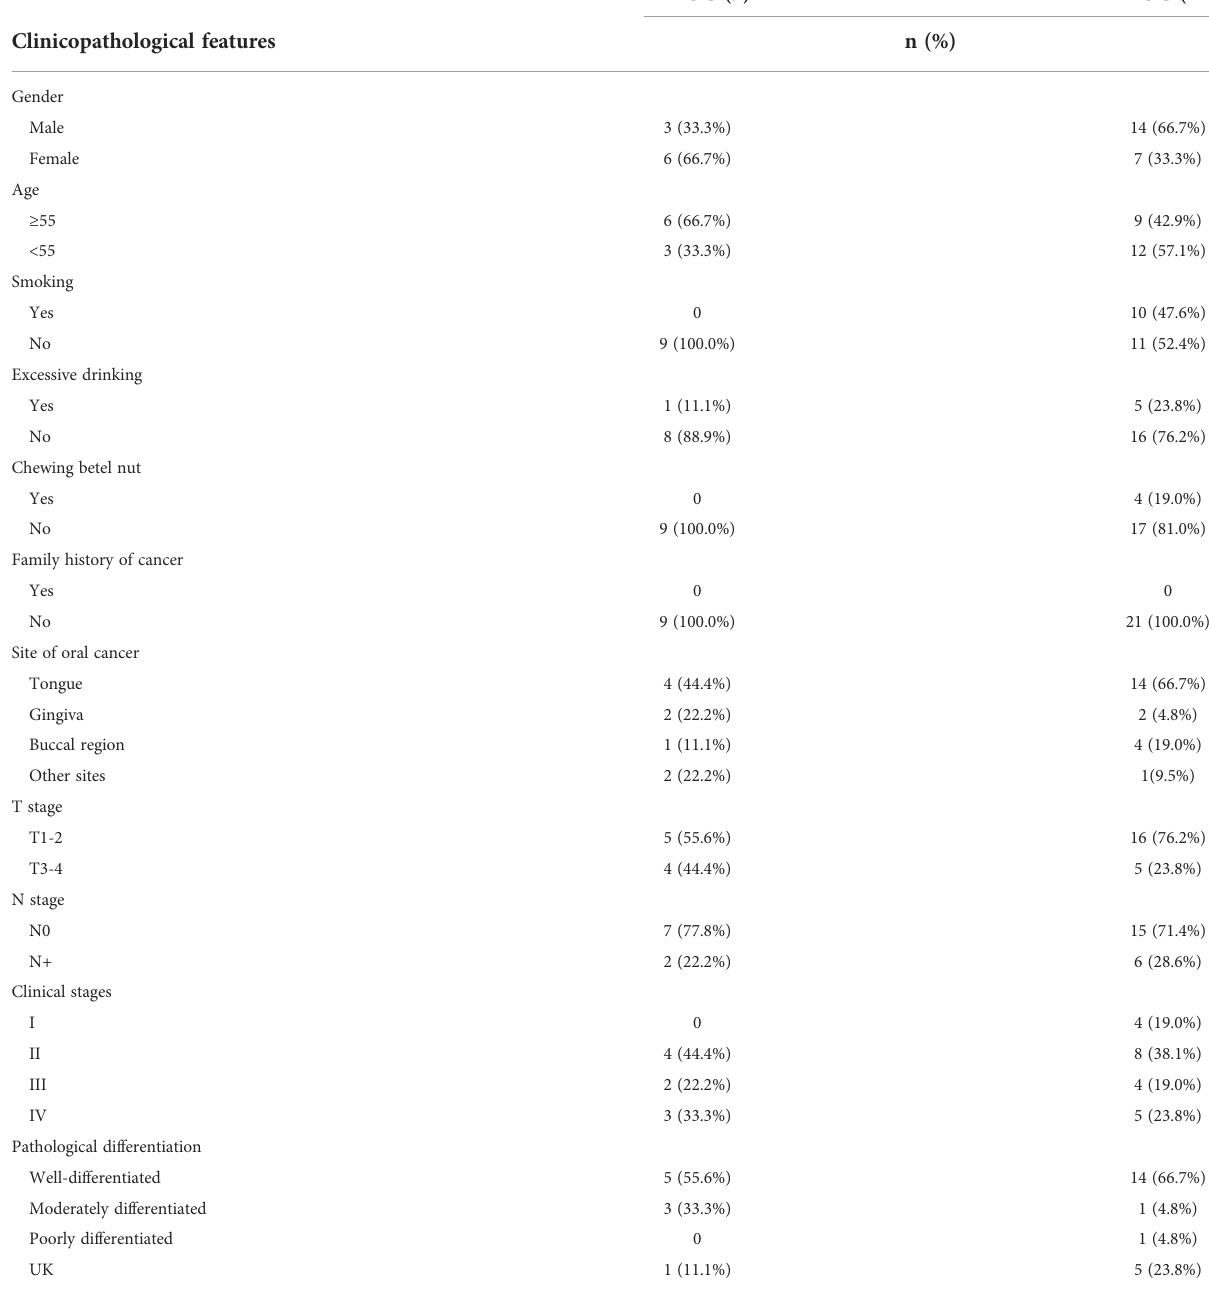
TABLE 2 Clinicopathologic features of 30 patients for whole exome